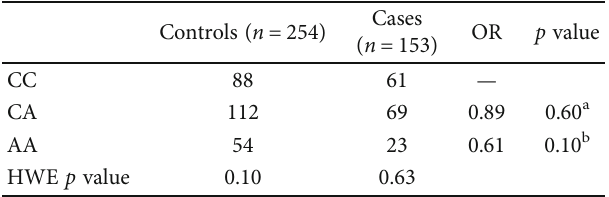
Figure 3: Violin plots representing AL589740.1 gene expression measured in transcripts per kilobase million (TPM) according to the GTEX portal (https://gtexportal.org). Signi fi cant expression is detected in di ff erent central nervous system areas, pituitary, and testis. Table 1: rs9320913 genotypes in the case and control